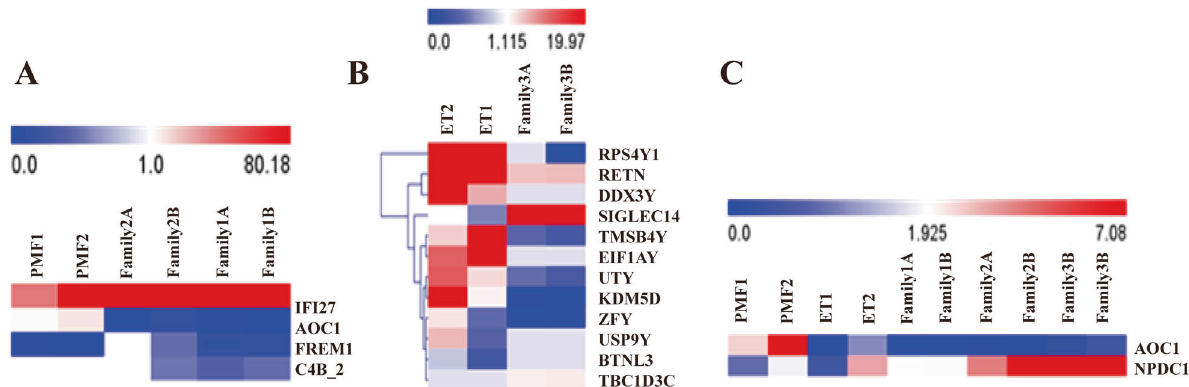
Fig. 2 Familial PMF with CHST15 mutation exhibits activation of immune/in fl ammation/extracellular matrix signals in PBMNCs. A Heatmap shows hierarchical clustering of expression pro fi les of 4 differentially expressed CHST15 target genes in familial PMF (red:upregulation;blue:downregulation). Microarray assay of genes with >2.0-fold upregulation or downregulation. B Familial essential thrombocythemia (ET) genes expression pro fi les. Heatmap shows hierarchical clustering of pro fi les of 12 differentially expressed genes. C Genes expression pro fi les both in familial PMF and in familial